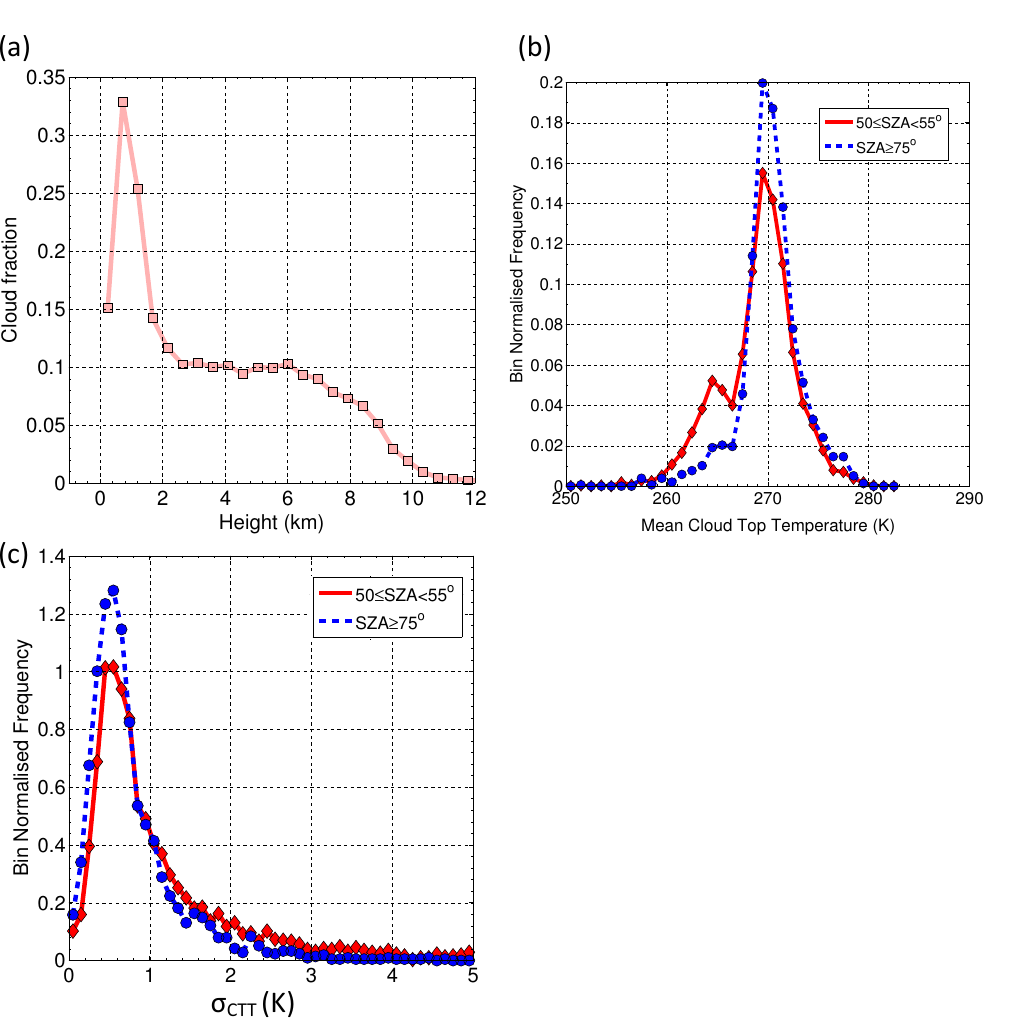
Figure 3. (a) CALIPSO cloud fraction vs. height for the month of June for the years 2007–2010. (b) PDFs of mean MODIS grid box cloud top temperature (CTT) for grid boxes containing liquid clouds only (restrictions 1–4 applied, see text) and for VZA ≤ 41 . 4 ◦ . The difference between the low and high θ 0 PDFs is highly likely to be due to phase determination problems at high θ 0 (see text for explanation). When considering clouds of all phases the PDFs are identical (not shown). (c) PDFs of the standard deviation of CTT within grid boxes for data points that have had restrictions 1–5 applied (see text) and for VZA ≤ 41 . 4 ◦ . All plots are for the region highlighted in Fig.